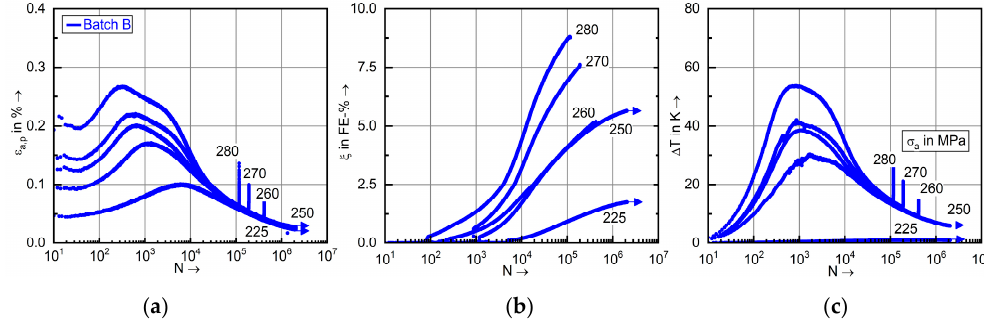
Figure 8. Development of ( a ) plastic strain amplitude ε a,p , ( b ) α ’-martensite and ( c ) change in the specimen’s temperature Δ T versus load cycles N during HCF tests at AT with f = 5 Hz of batch B. specimen’s temperature ∆ T versus load cycles N during HCF tests at AT with f = 5 Hz of batch